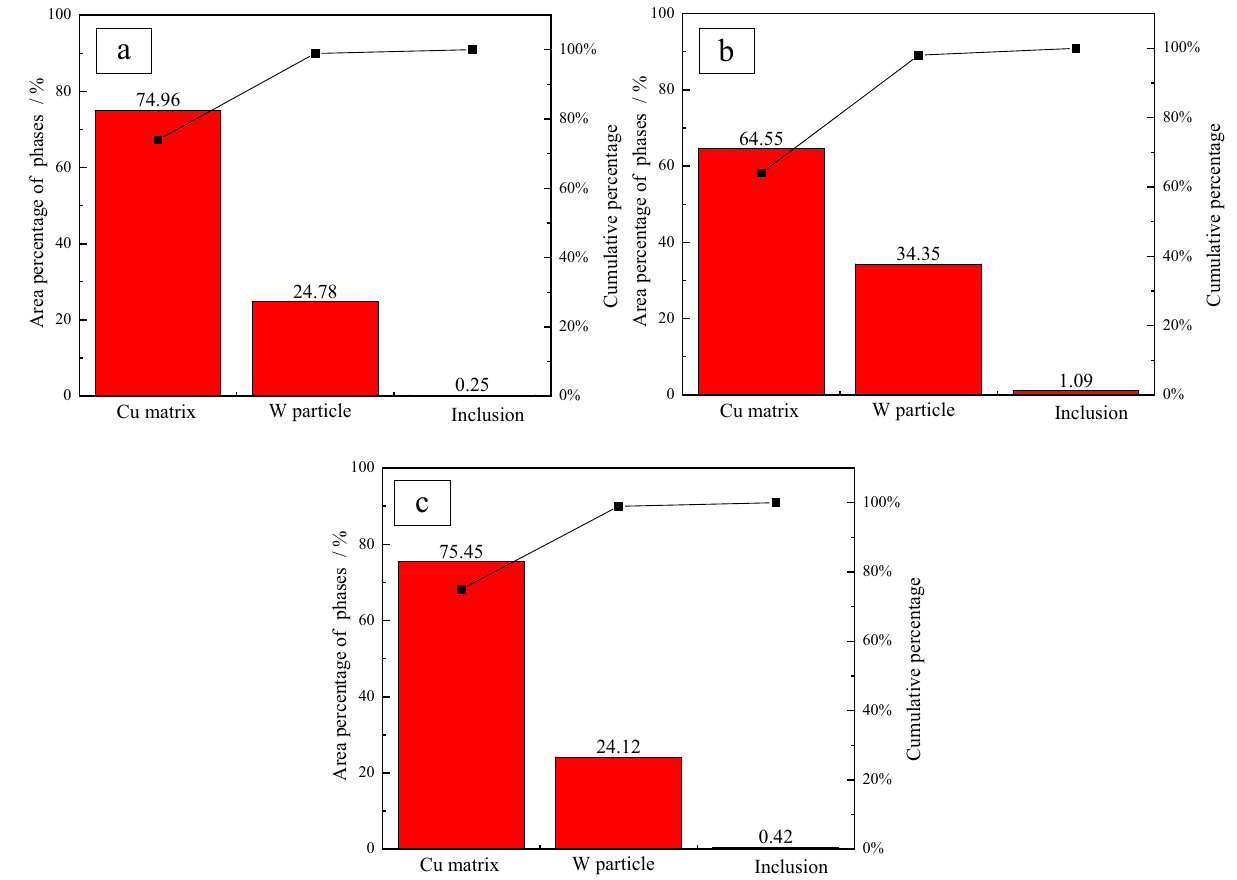
Figure 4: Phase distributions of microstructure in WCu composites microalloyed with ( a ) Fe, ( b ) Ni, and ( c )